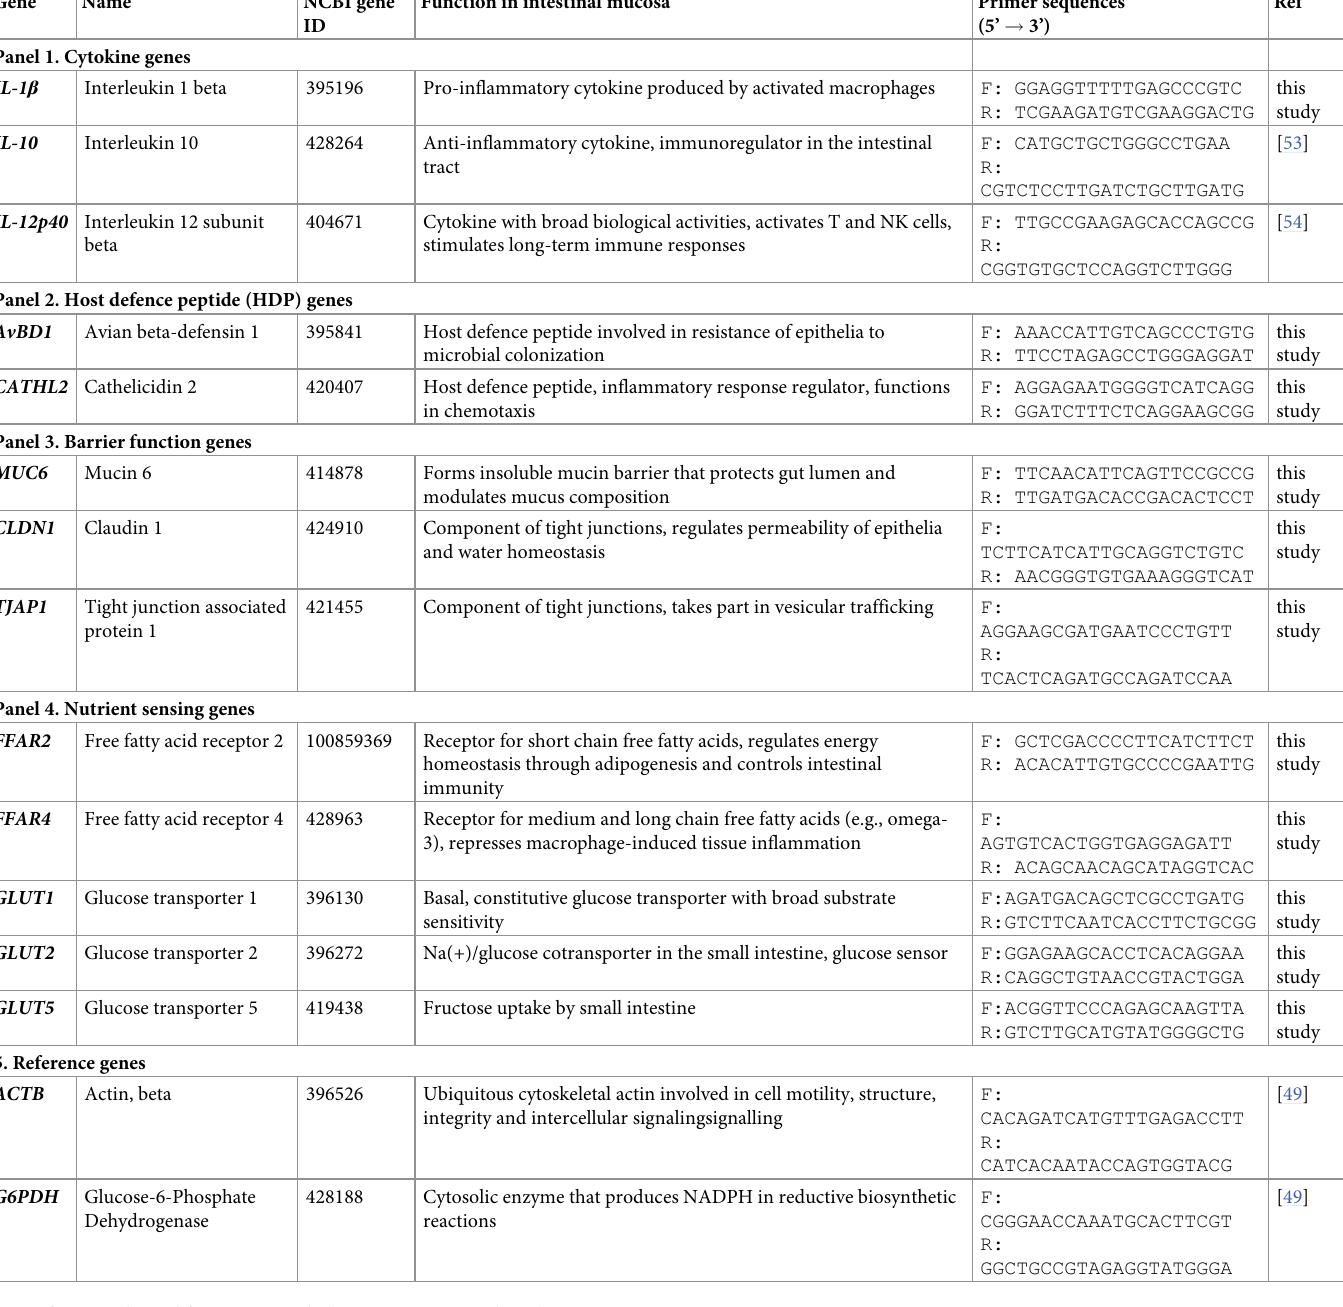
Table 2. Molecular function of the intestinal genes primer sequences used for